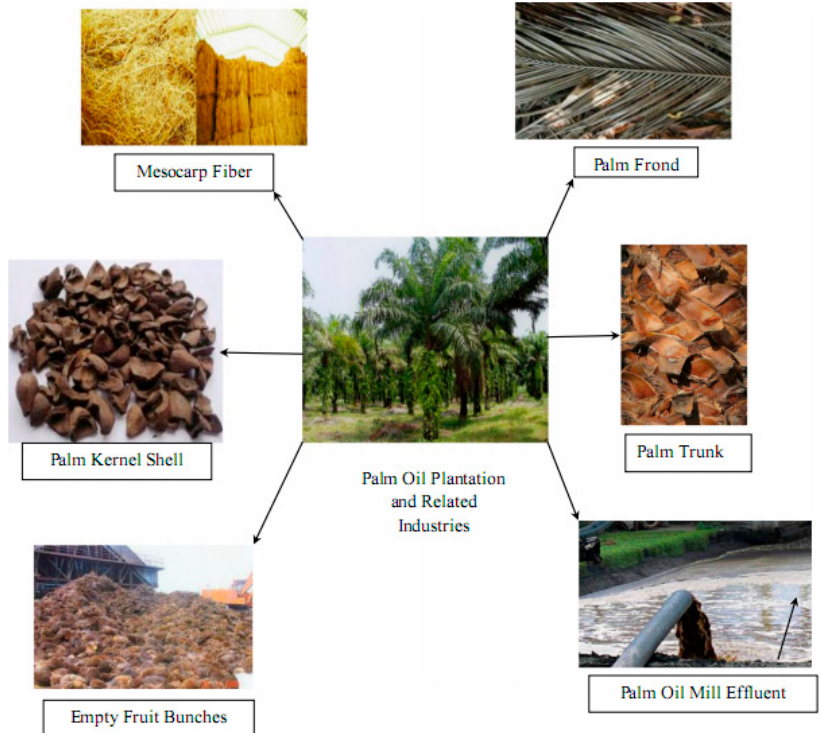
Figure 1. Malaysian palm oil plantation and industry [10]. Reprinted with permission from Elsevier [10].